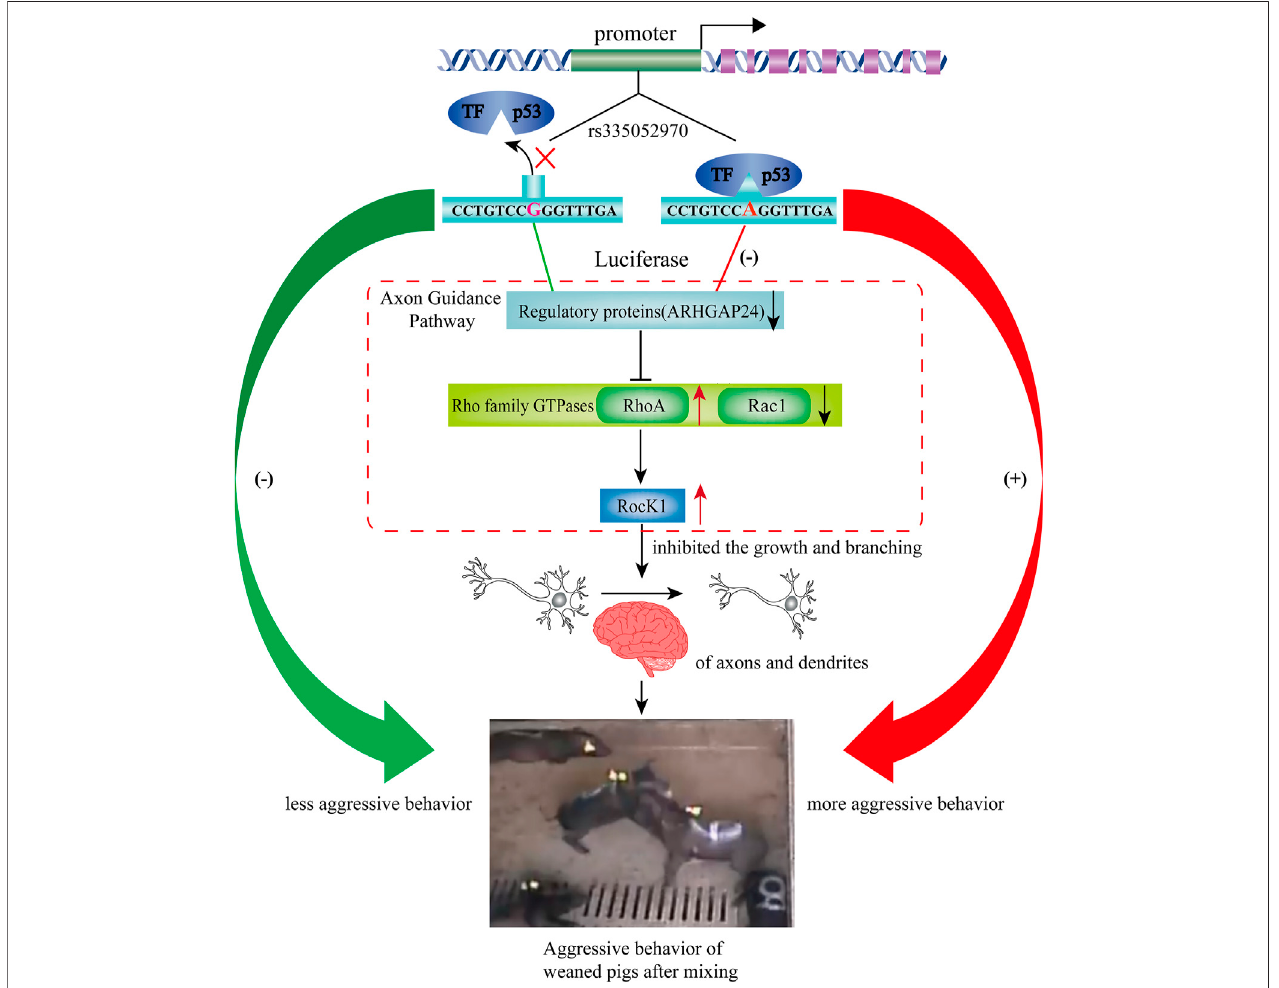
FIGURE 7 | Based on the results, we hypothesized a regulating pathway by rs335052970 on the aggressive behavior of weaned pigs after mixing. Based on the results, we hypothesized a regulating pathway by rs335052970 in the ARHGAP24 gene on the aggressive behavior of pigs. In this diagram, rs335052970 binds to the transcription factor p53 to form a complex that regulates ARHGAP24 gene expression. Speci fi cally, the promoter with allele A is more capable of binding to the transcriptional repressor p53 and downregulates ARHGAP24 gene expression. Since RhoA and RocK1 are the downstream targets of ARHGAP24, p53 also activates the expression of RhoA and Rock1. This might reduce the growth and branching of axons and dendrites, which make pigs more aggressive after weaning. Consequently, the promoter with allele A of rs335052970 upregulates the aggression of weaned pigs after mixing.